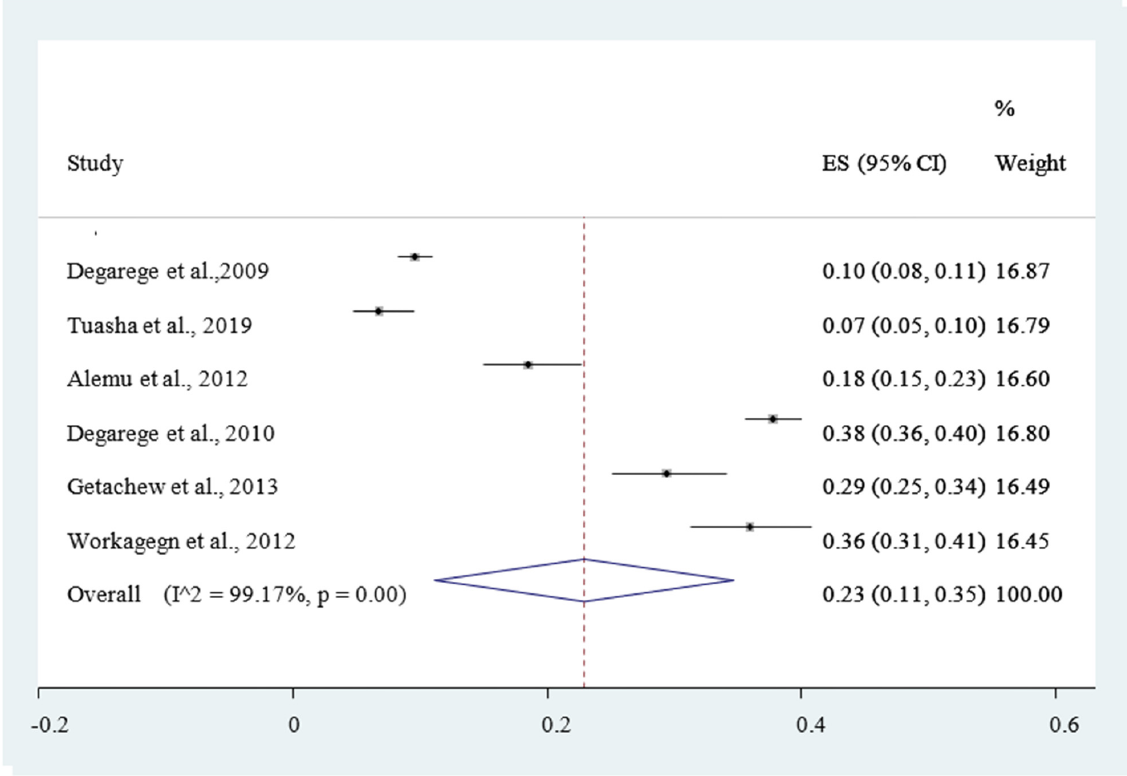
Figure 7. Forest plot of 6 studies on magnitude of Hookworm infection among outpatients in Ethiopia, 2020.